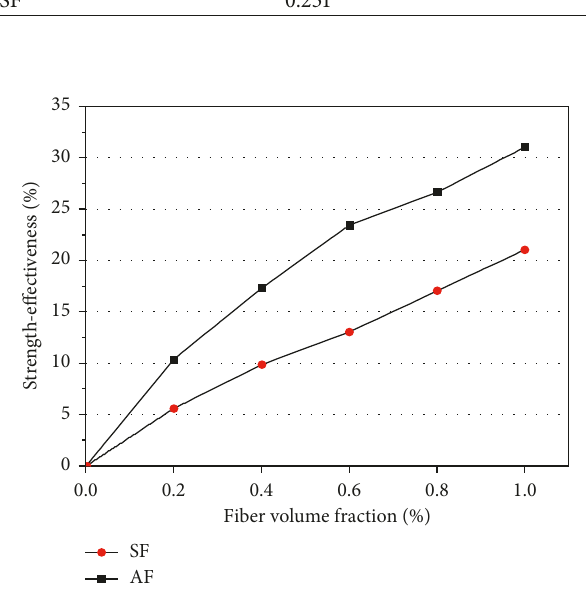
Figure 2: Splitting strength-effectiveness of